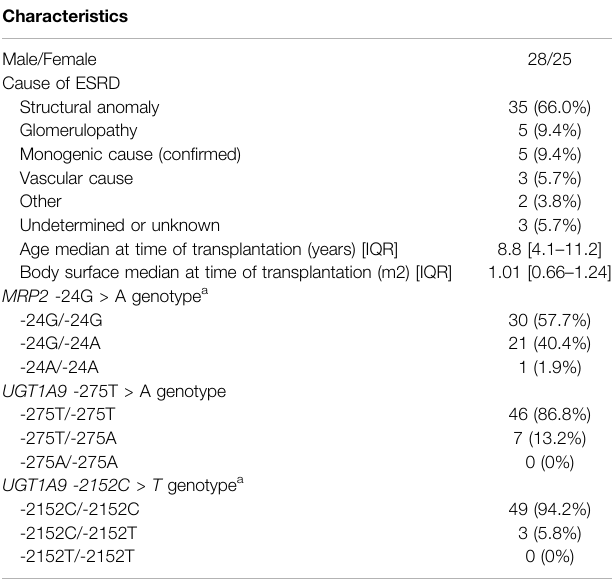
TABLE 2 | Basic clinical characteristics and MRP2 / UGT1A9 genotypes of 53 pediatric kidney recipients. Characteristics